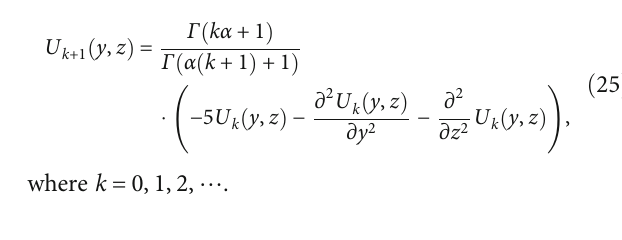
Figure 2: The FRDTM solutions u ð x , y , z Þ : (a) α = 1 : 8 and (b) α = 1 : 4 .